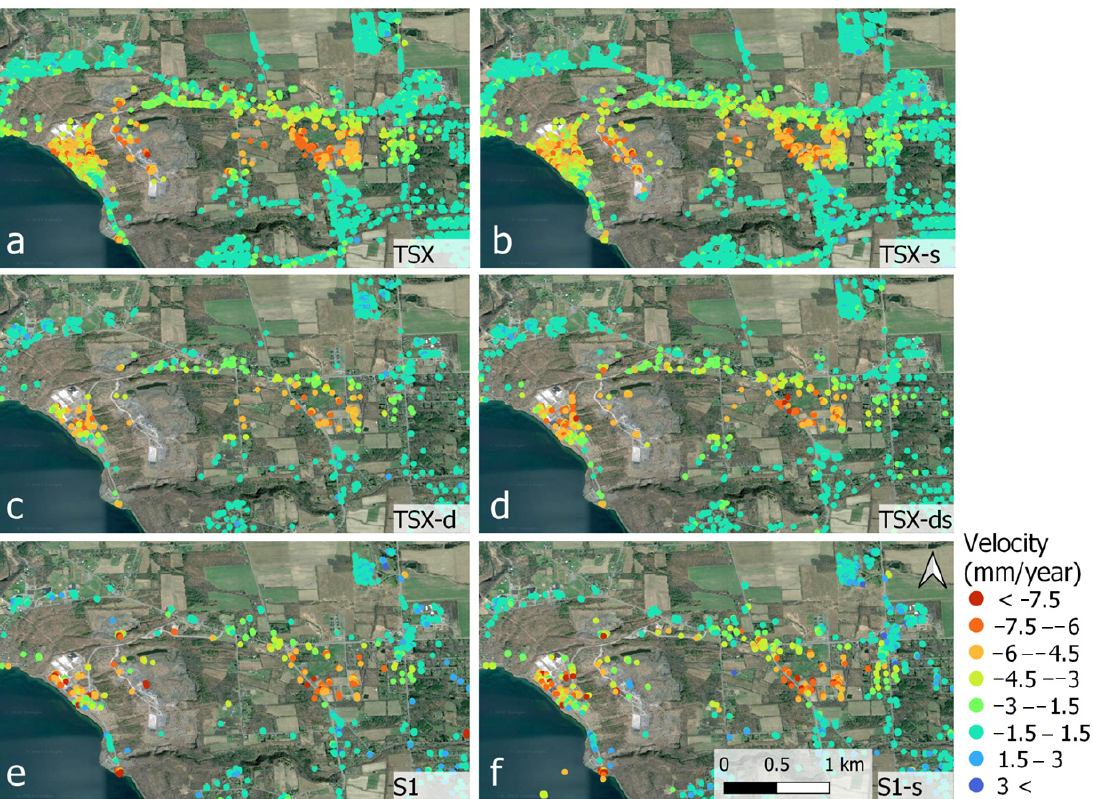
Figure 6. Displacement rates extracted over Lansing and the Cayuga Salt Mine (CSM) using TSX ( a ), TSX-s ( b ), TSX-d ( c ), TSX-ds ( d ), S1 ( e ), and S1-s ( f ). The displacements were converted from the radar line sight (LOS) to vertical deformations while assuming that all deformations were vertical. The area shown in this fi gure is labeled “c” in Figure 1. Basemap imagery available through Google: imagery CNES/Airbus, Maxar Technologies, New York GIS, USDA/FPAC/GEO; map data @2023.